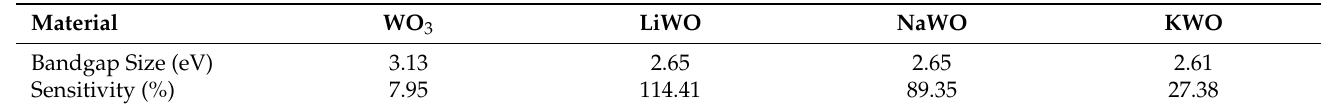
Table 2. Comparison of band gap size to sensitivity percentage to 2.86 ppm acetone for alkali doped WO 3 at room temperature [44].